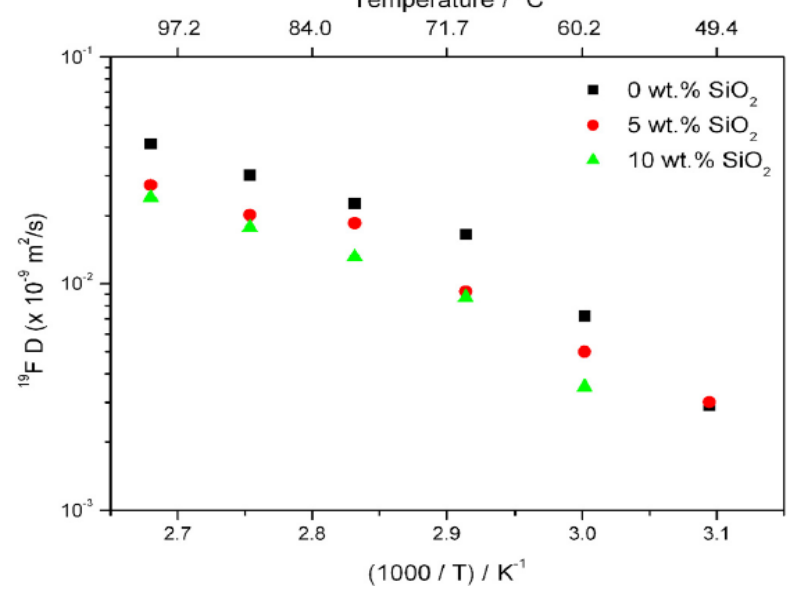
Figure 6. Arrhenius plot of 19 F self-diffusion coefficients for PEO 20 :NaTFSI + x% by wt. SiO 2 (x = 0, 5,